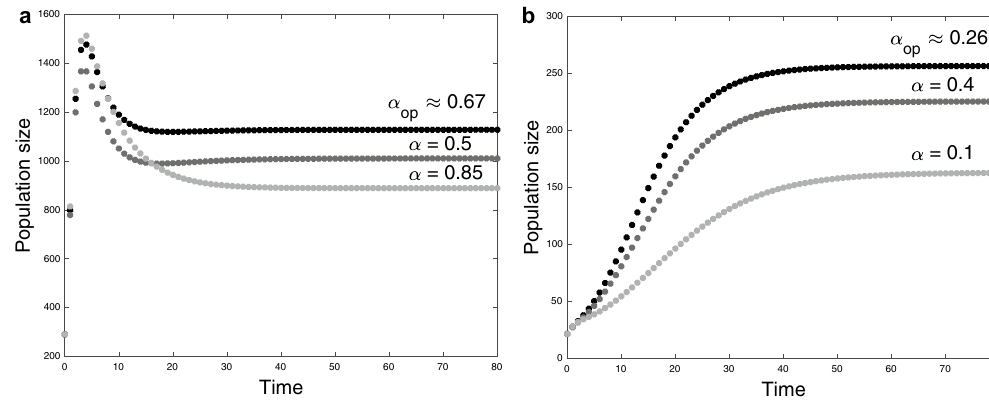
Figure 6. Comparison of the long-term behavior of the population size after the reproductive season (population component of the system (6)) using various allocation strategies towards reproduction. ( a ) We consider the parameter set η = ( 2, 1, 1, 0, 200, 2, 2, 1 / 3, 0.1, 0.39, α , 0.2 ) with α ∈ { 0.5, 0.67, 0.85 } and ( b ) η = ( 2, 1, 0.5, 0, 400, 1, 2, 1 / 3, 0.1, 0.63, α , 0.2 ) with α ∈ { 0.1, 0.26, 0.4 } . In both cases, the constant of fertility costs is described by κ = ( 1 + γ) − 1 . In addition, note that in ( a ) � = 2 / 3 > δ ≈ 0.165 and ( b ) � = 1 / 3 < δ ≈ 2.718